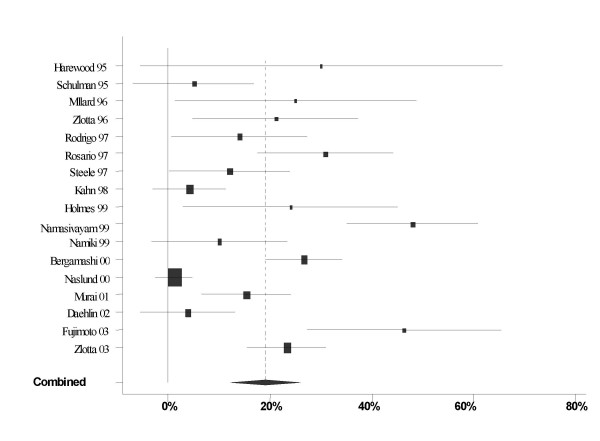
TUNA. Non-comparative studies. Rate of secondary interventions. Random effects model.